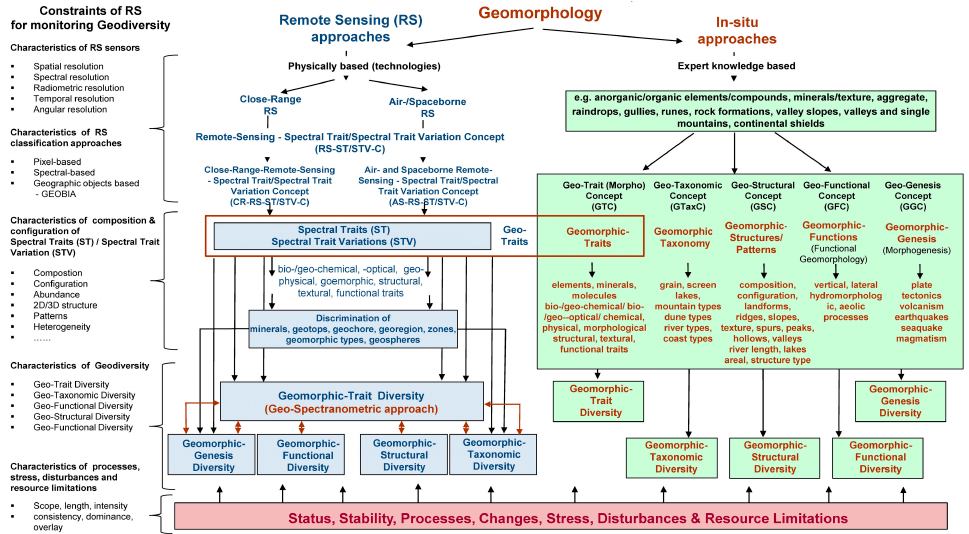
Figure 13. In-situ and remote sensing (RS) approaches and their limitations for monitoring geomorphology, its traits and its five characteristics (modified after Lausch et al., [3]).